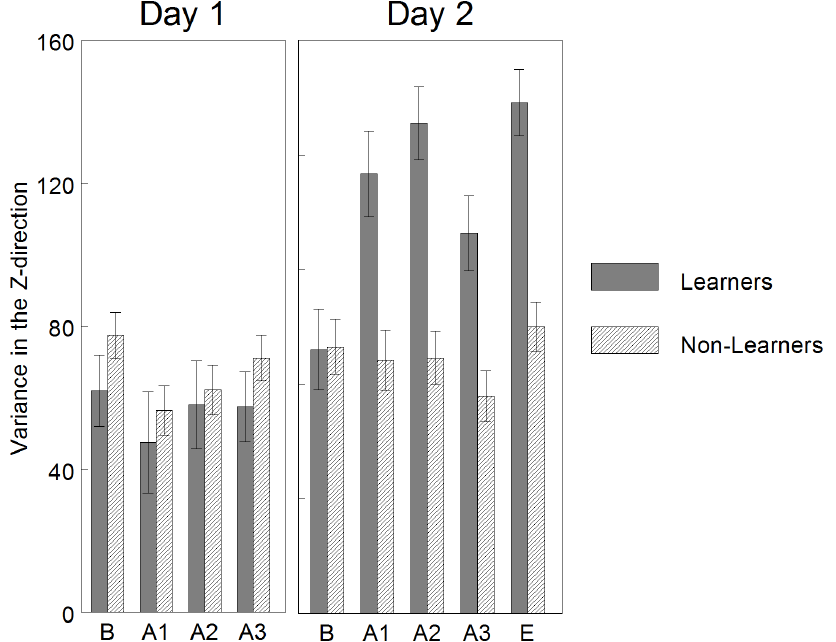
Figure 6. Learners versus non-learners: mean variance in the vertical, task specific direction, by interval. On Day 1, there were no significant differences in variance. On Day 2, between-group variance during each interval, except baseline, was significantly increased in the Learner group as compared to the Non-Learner group. Within-group, the Learner group demonstrated a significant increase in variance in the A1, A2, and E intervals as compared to baseline (performance criteria). Within-group, the Non-Learner group did not demonstrate a significant change between baseline and any acquisition interval (performance criteria). This can be interpreted as the Learner group demonstrated more variance when interacting with the mobile on Day 2, but not Day 1. The Non-Learner group did not demonstrate a change in variance either day. Error bars are standard errors. B=baseline, A=acquisition, E=extinction.